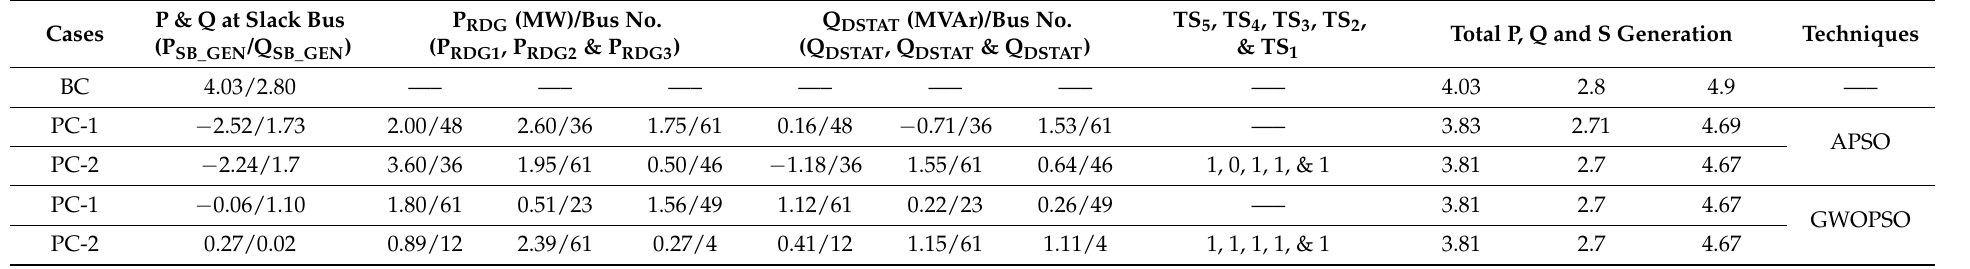
Table 9. Simultaneous optimal planning of DGs (in MW and MVAr) with and without reconfiguration of 69-bus RDN.